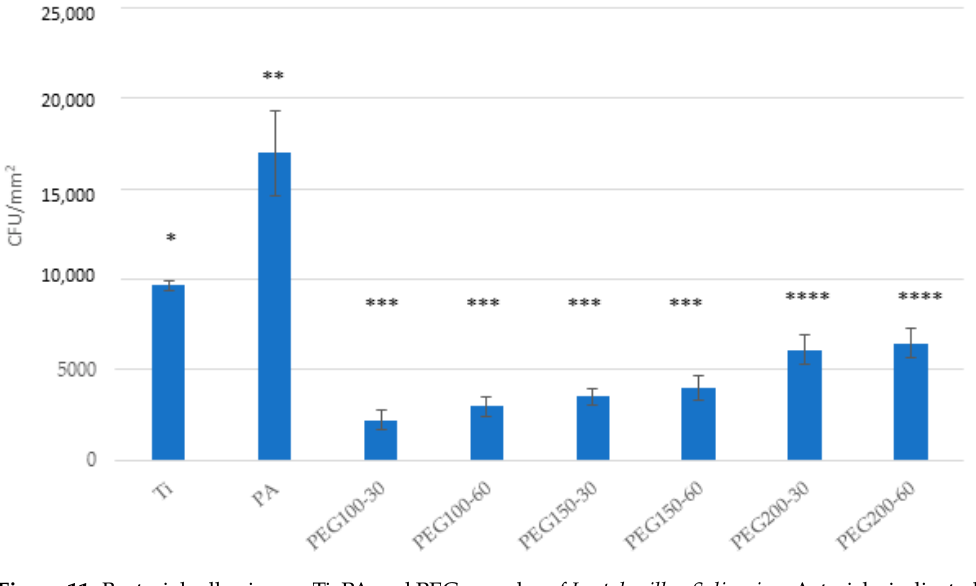
Figure 11. Bacterial adhesion on Ti, PA and PEG samples of Lactobacillus Salivarius. Asterisks indicated with the same symbol have no statistically significant difference between them ( p > 0.05).